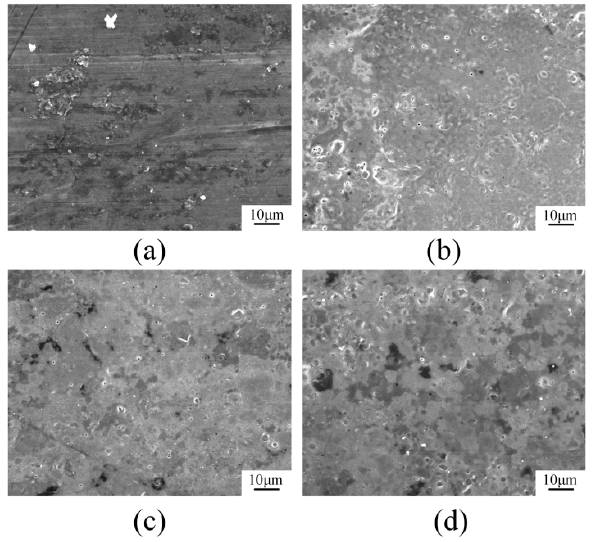
Figure 5. Scanning electron microscopy surface microstructure of aluminum alloy cleaned